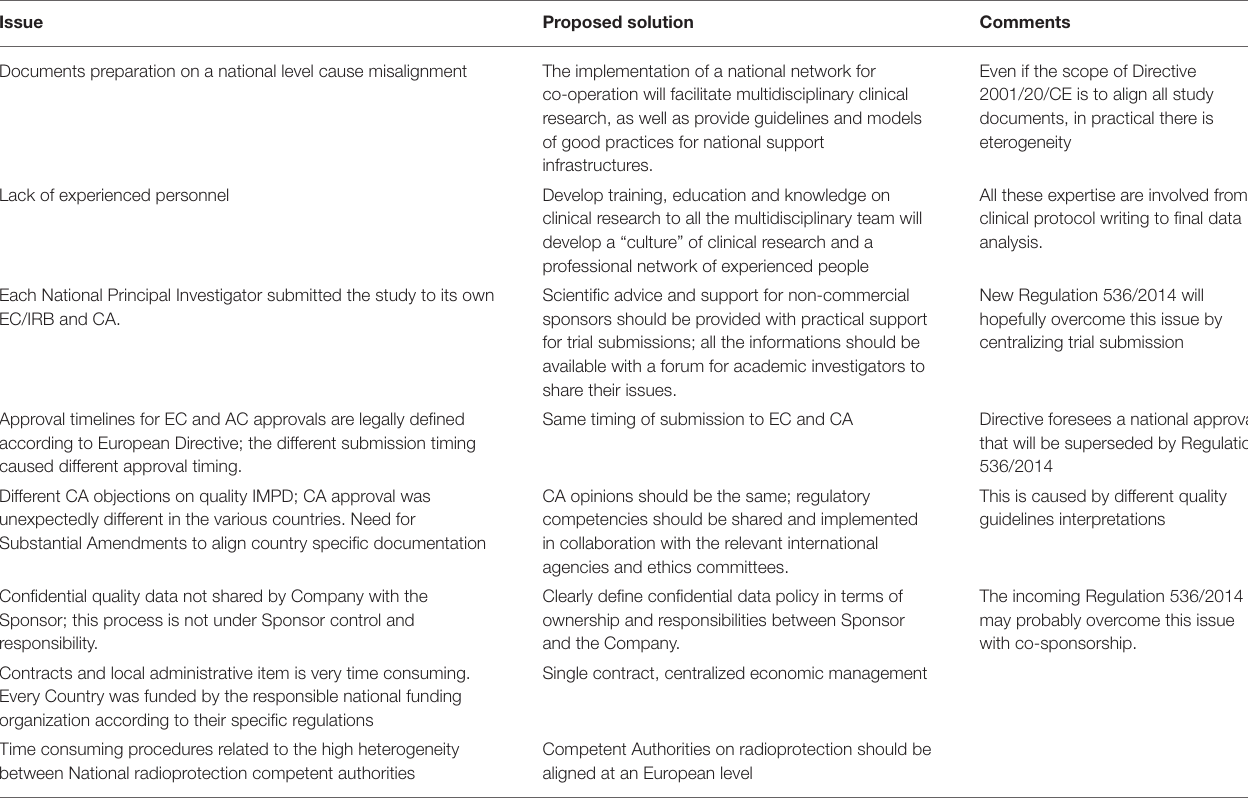
TABLE 3 | Main barrier details and possible